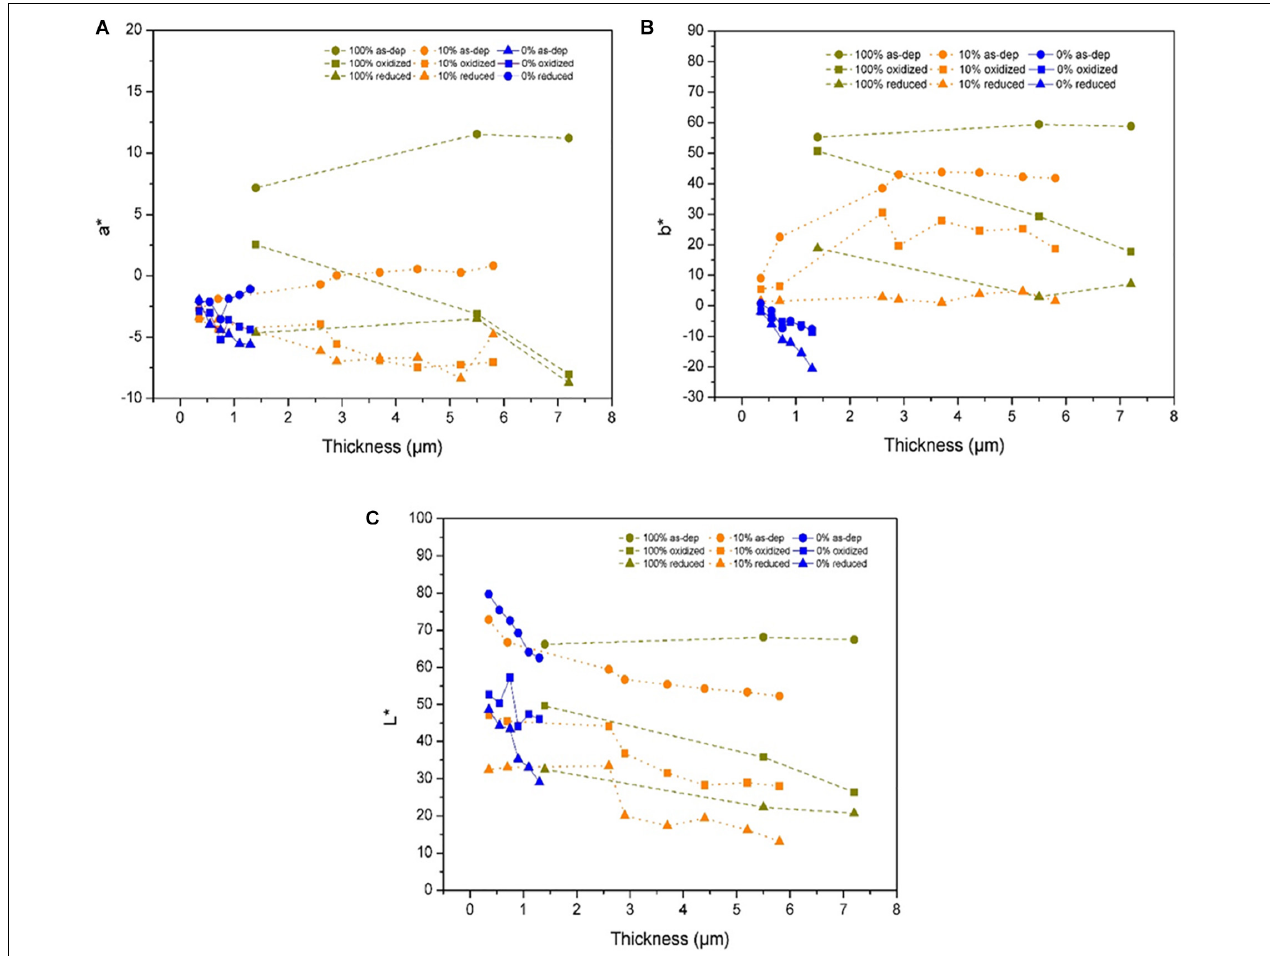
FIGURE 9 | Comparison of the chromaticity parameters between initial, oxidized state at E = +1.5 V and reduced state at E = –1 V with (A) parameter a*. (B) parameter b*. (C) parameter L* for 100 wt% V 2 O 5 10 wt% V 2 O 5 , and 0 wt% V 2 O 5 .